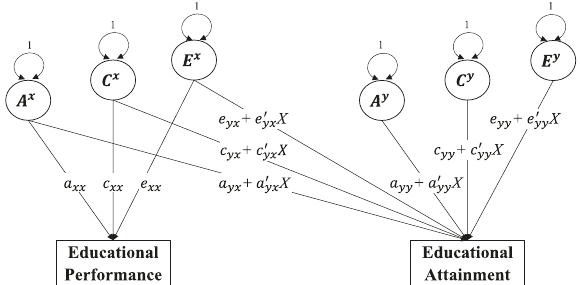
Fig. 4 Bivariate twin moderation model with Cholesky decom- position: effects on attainment moderated by performance. The genetic ( A ), shared environmental ( C ), and non-shared environ- mental ( E ) effects on educational attainment are divided into a part that is common with performance (see paths a yx , c yx , and e yx ) and a part that is unique to attainment (see paths a yy , c yy , and e yy ). The size of these paths depends on the moderator educational performance ( X ). For simplicity, only one twin is shown, but the second twin could be added as in Fig.